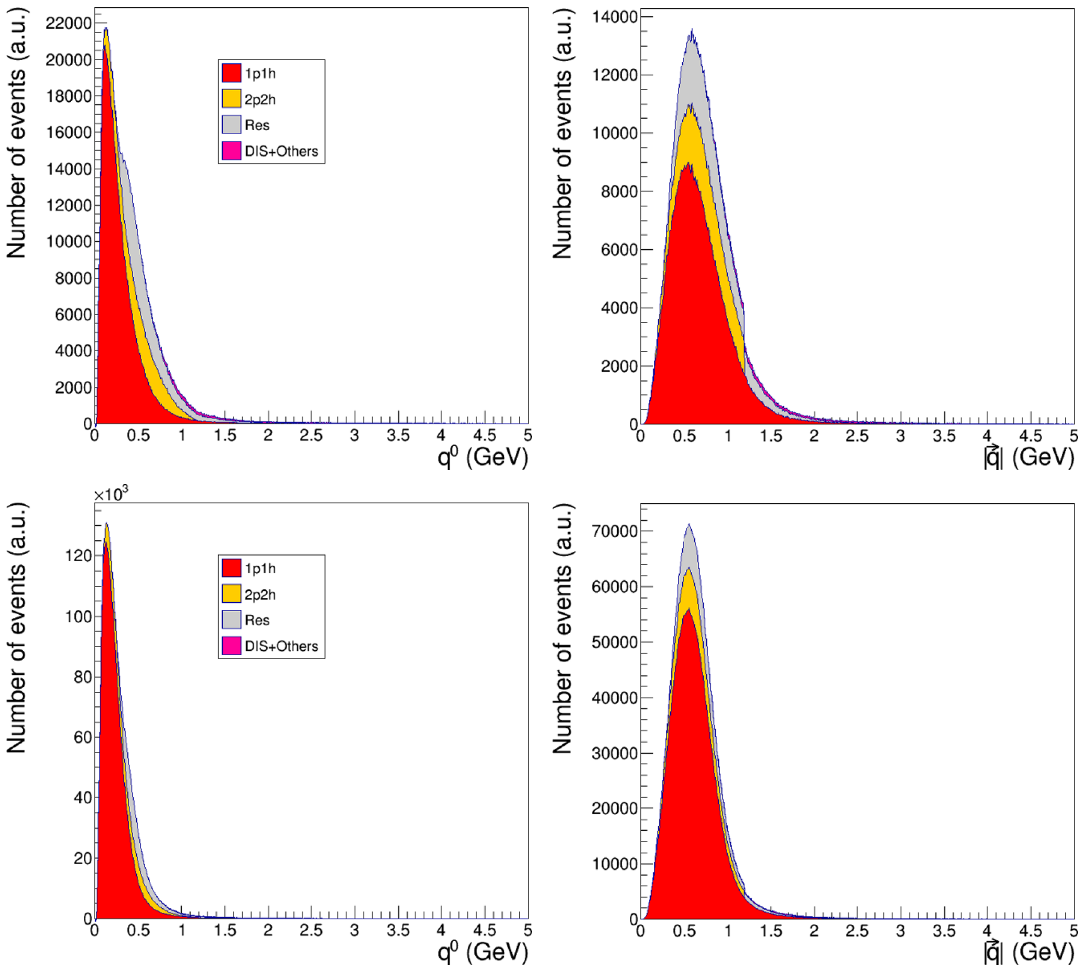
Figure 26 . The same as figure 25 for CC0 π